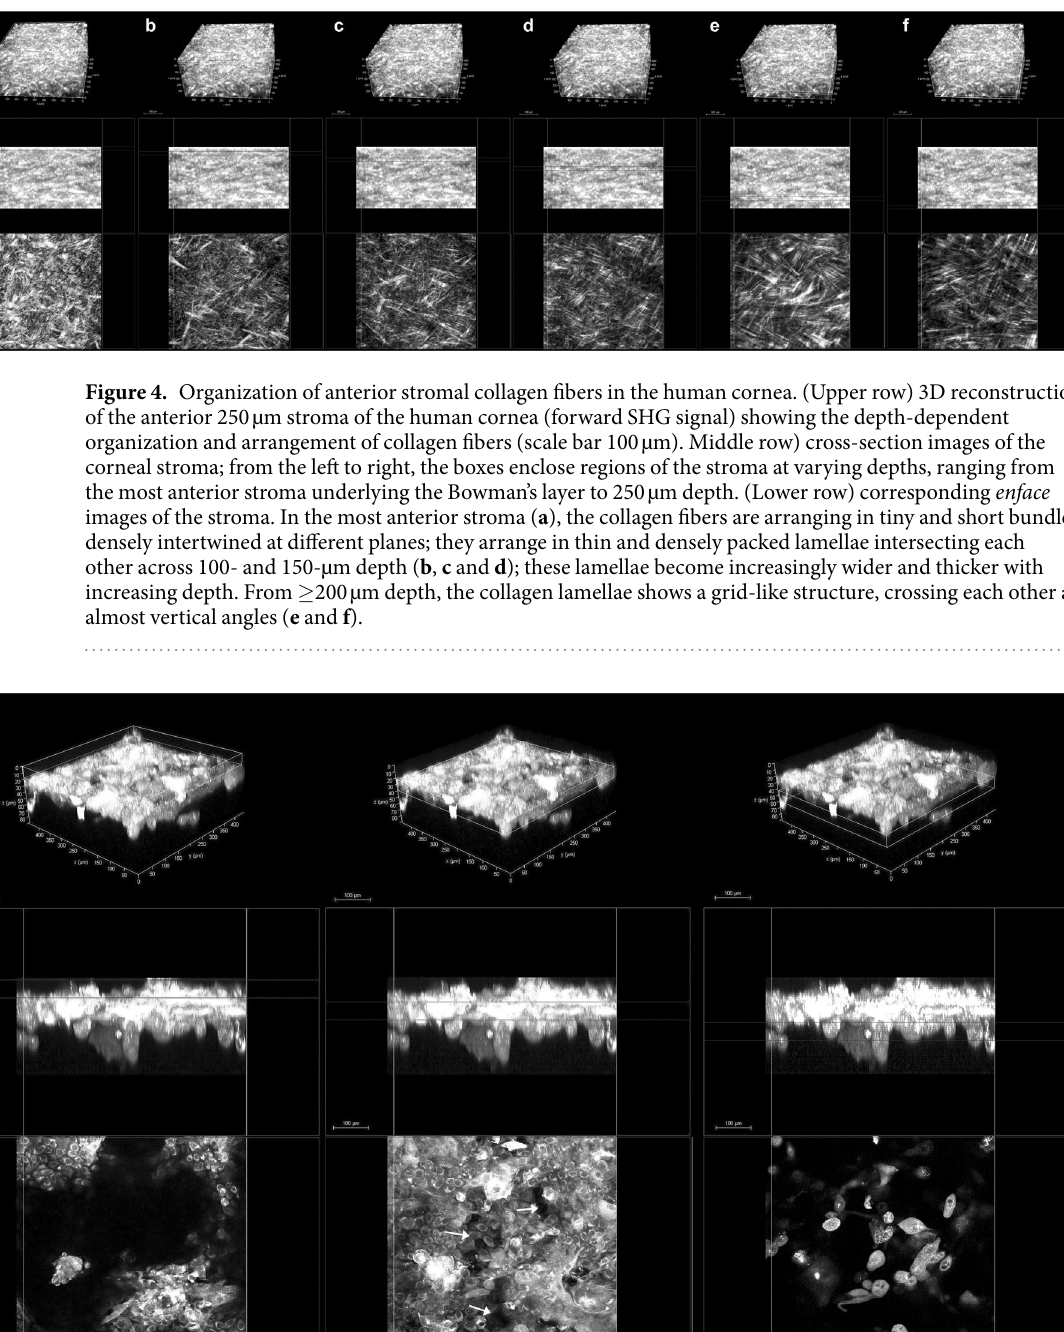
images in terms of orientation for the stromal collagen fibers with differences within 15 degrees up to 65 µ m stromal depth in the hemicornea (mean Δγ = 4.4 ± 5.3 degrees) and control anterior stromal lenticule (mean Δγ = 4.0 ± 7.0 degrees) respectively. The forward to backward second harmonic generations ratio, F/B, showed